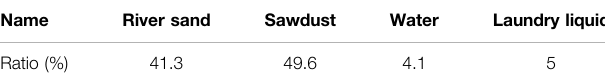
TABLE 5 | Mixture ratio of simulated Class-V surrounding rock. TABLE 6 | Seismic loading scheme for shaking table